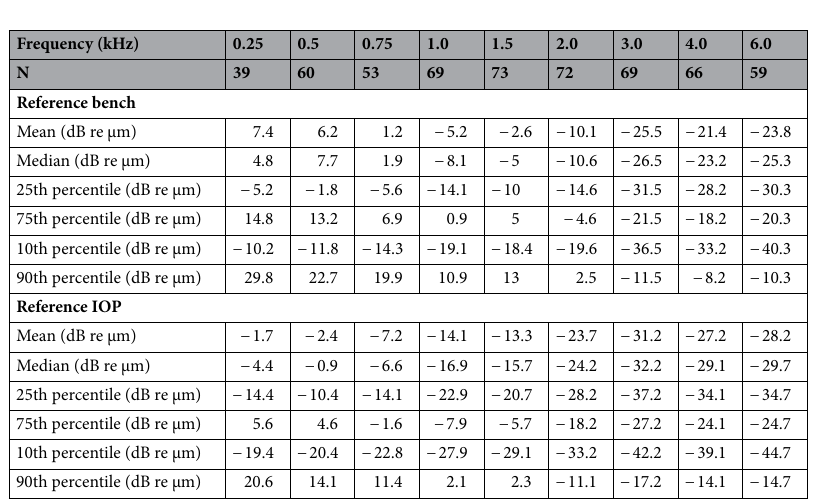
Table 3. Piston displacement amplitude for 94 eq dBSPL at the tympanic membrane of all patients (N =